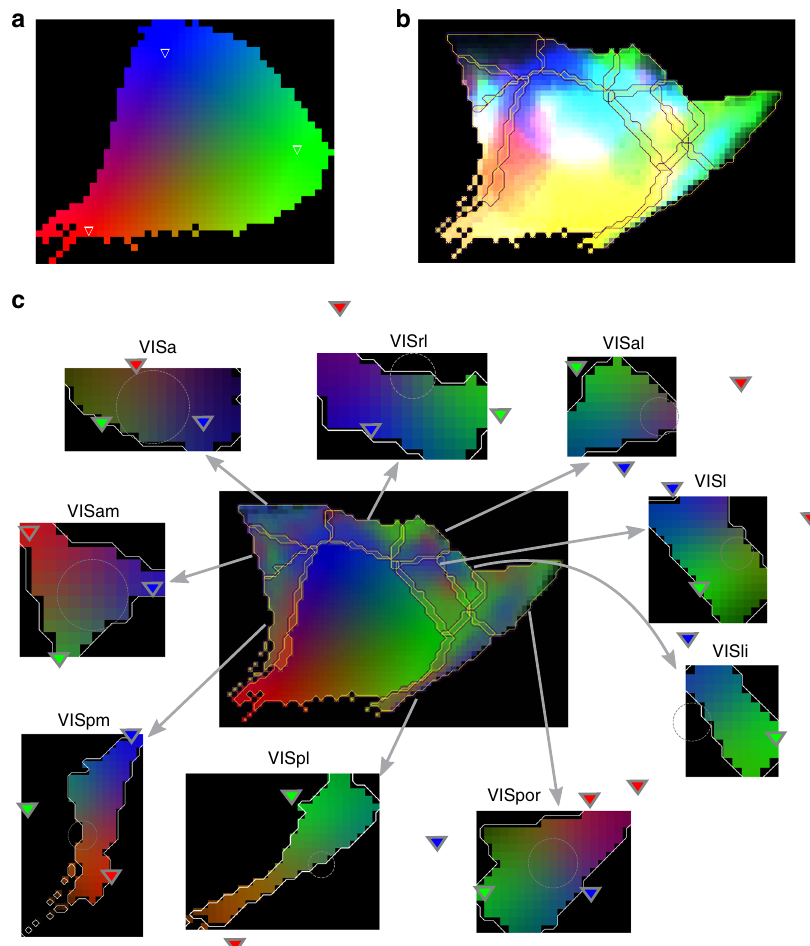
Fig. 3 Projection mapping in the visual system. a The primary visual area (VISp) and its de fi ned source coordinate system. The three points de fi ning the barycentric system are indicated as colored triangles. Each coordinate is associated with the indicated red, green, or blue color channel to decide the color of each pixel in the region. b The spatial structure of projections from VISp is indicated by coloring pixels in the surrounding regions according to the color in a of the area they are innervated from. c Center: as in b , but the color of each pixel is normalized such that the sum of the red, green, and blue channels is constant. Periphery: target coordinate systems for the surrounding regions were fi t to recreate the color scheme of the center, when colored as in